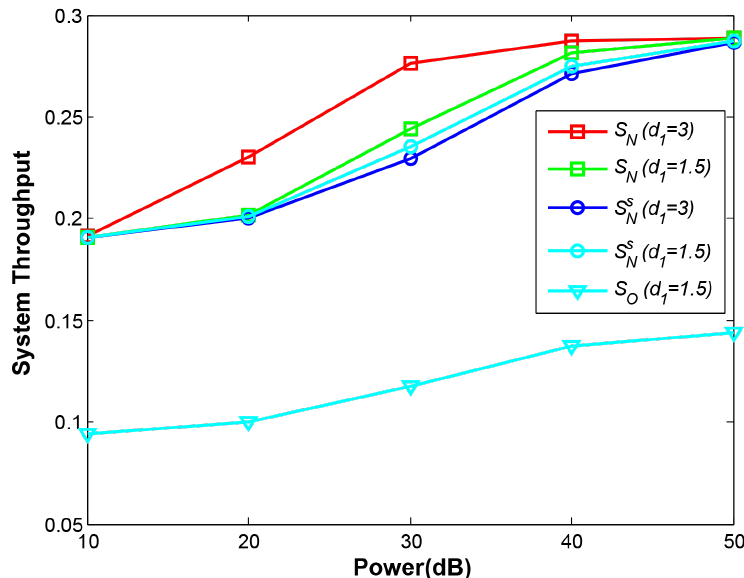
Figure 12. System throughput vs. total transmitting